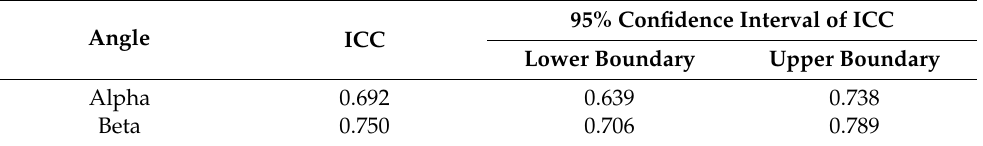
Table 4. Intra-rater reliability of the alpha angle and the beta angle for developmental displacement of the hip Figure 6. Scatter plot of alpha angles measured before and after birth ( n = 324). Dashed line indi- cates the linear correlation between the two measurements.